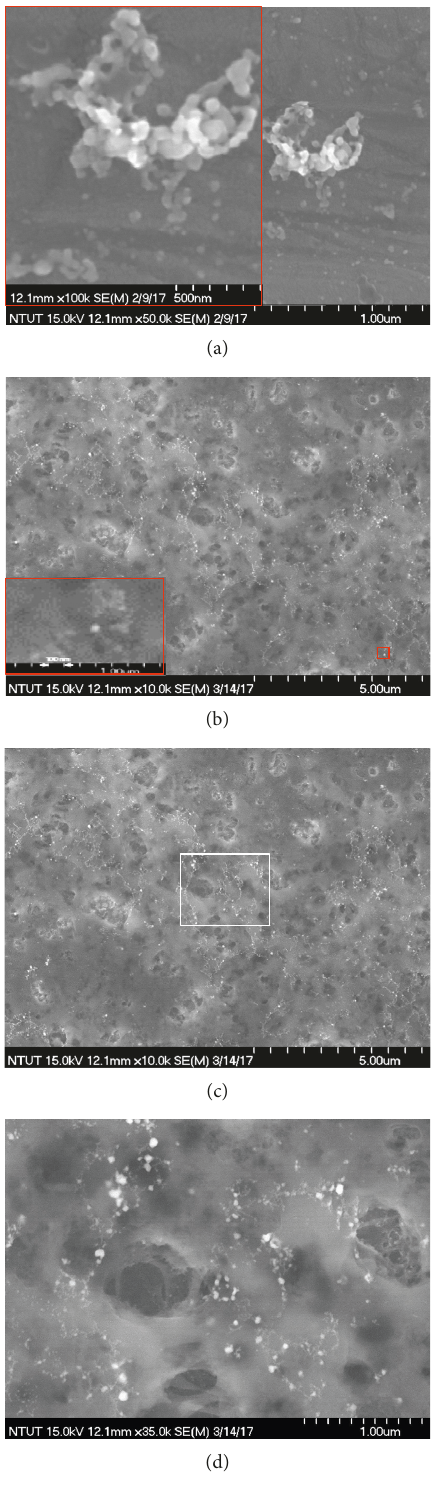
Figure 5: (a) SEM diagram of aggregated silver nanoparticles. (b) SEM diagram of silver+ 0.5% PVA particles. (c) 3D structure of nanocolloid distribution. (d) Zoomed in picture of the 3D structure of the nanocolloid.